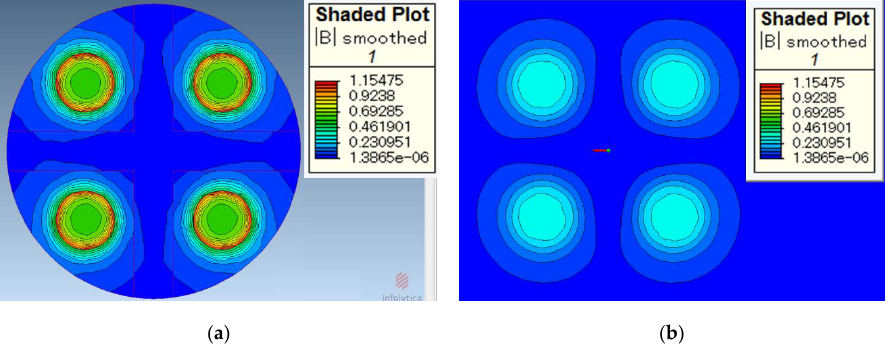
Figure 5. Simulation of magnetic induction. ( a ) magnetic induction on the surface of processing tools and ( b ) magnetic induction on the surface of the workpiece (working gap 1 mm).